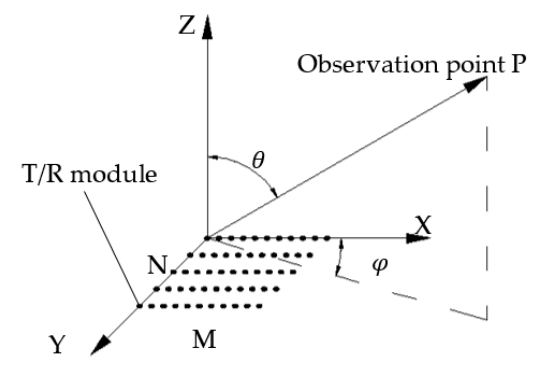
Figure 6. Schematic diagram of a rectangular array of the phased array antenna (PAA).